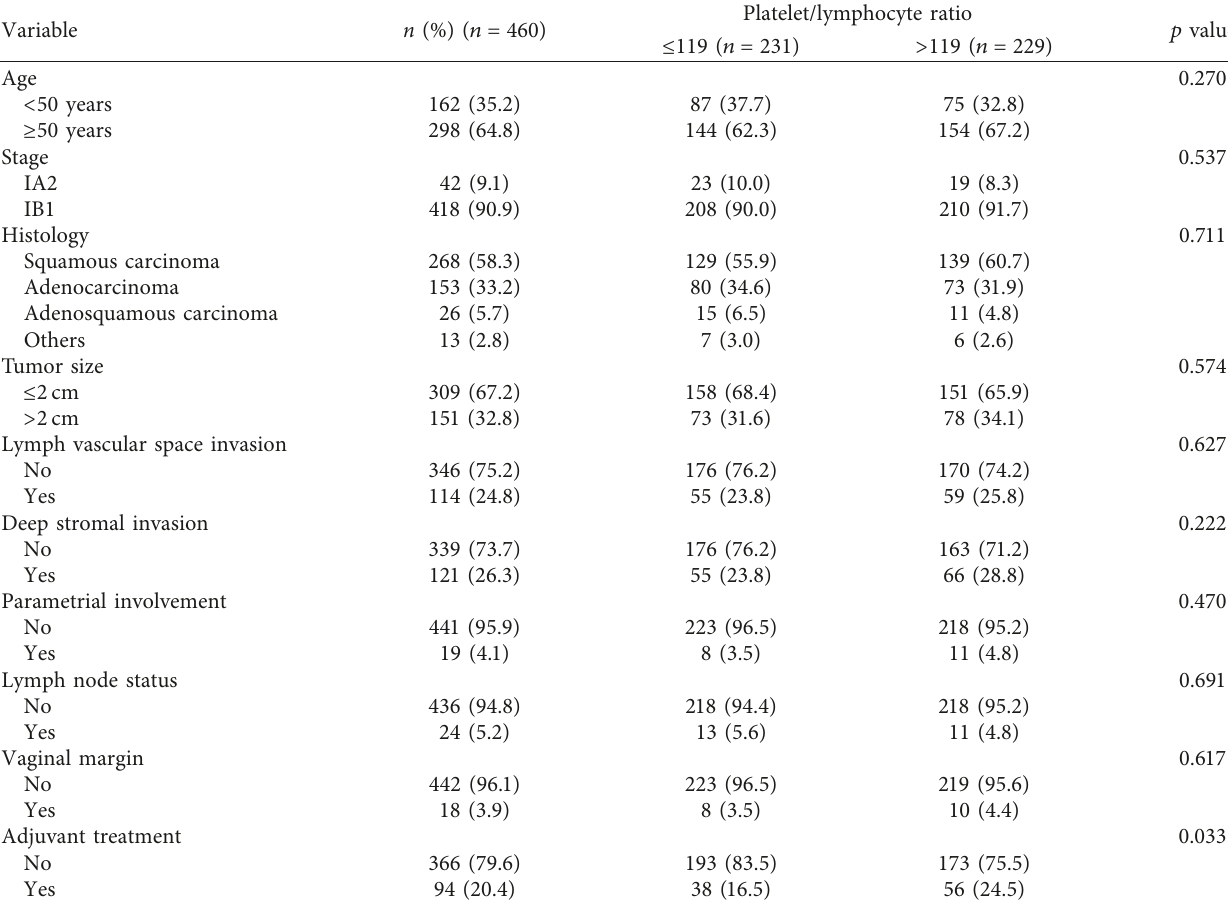
Table 2: Clinicopathological characteristics according to platelet/lymphocyte